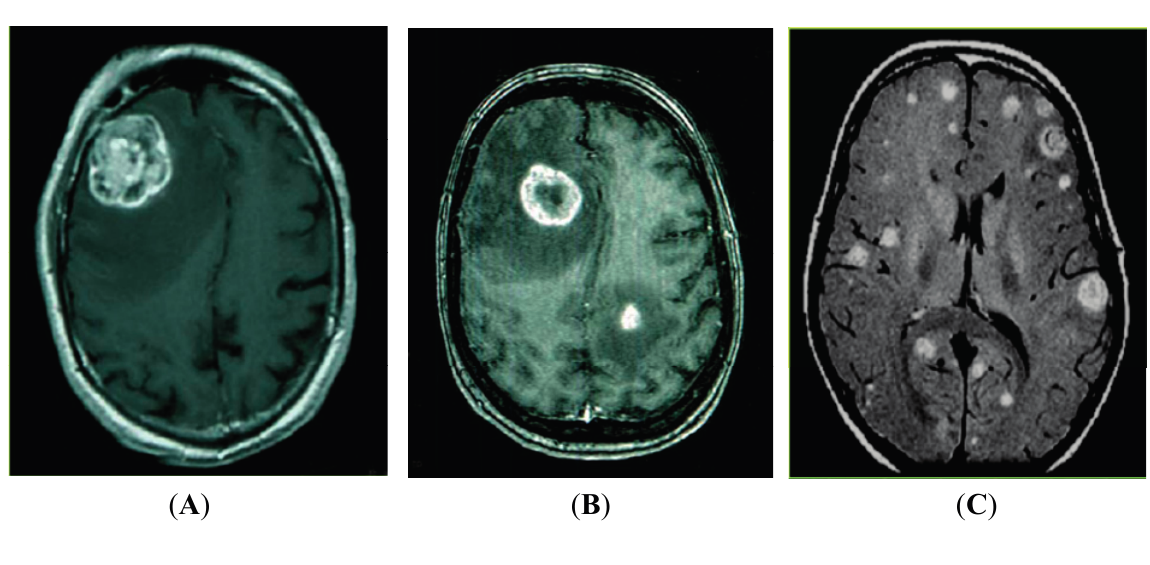
Figure 1. Magnetic resonance imaging (MRI) detection of brain metastasis. ( A ) Solitary lesion; ( B ) Oligometastasis; ( C ) Multiple brain